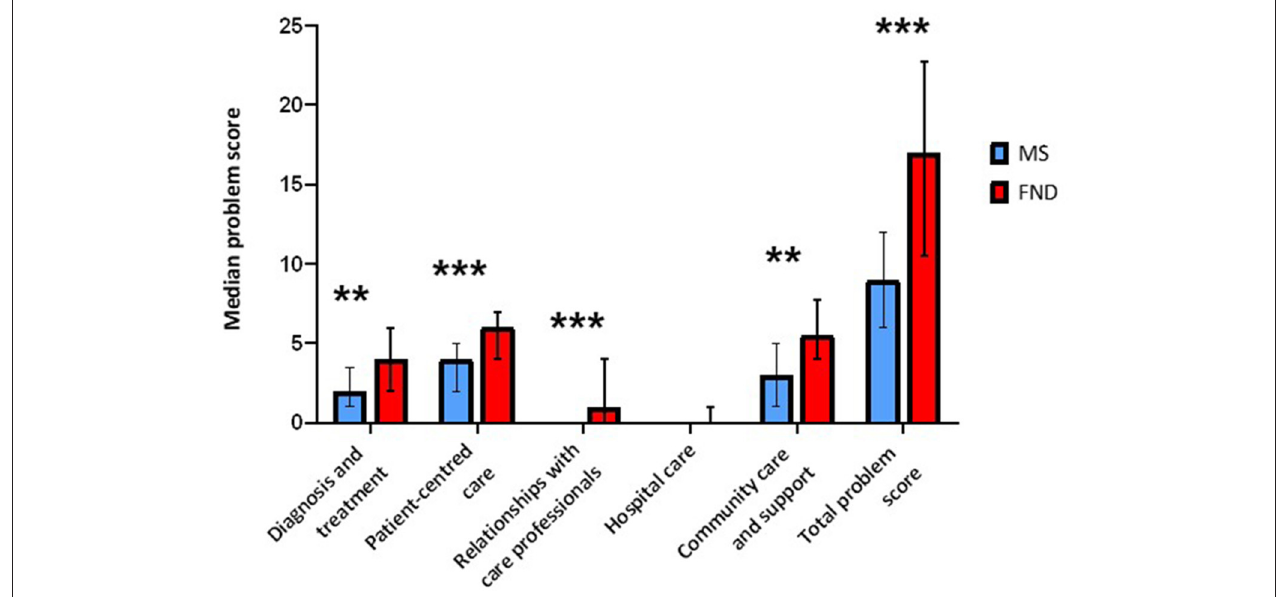
FIGURE 1 | Median problem scores for each patient group across all domains and in total. There were significant differences between the patient groups for all domains except the hospital care domain. Error bars represent the upper and lower quartiles of the median asterisks denote a significant difference in medians between the patient groups at the p < 0.050 level, with ** indicating significance at the p < 0.010 level and *** indicating significance at the p < 0.001